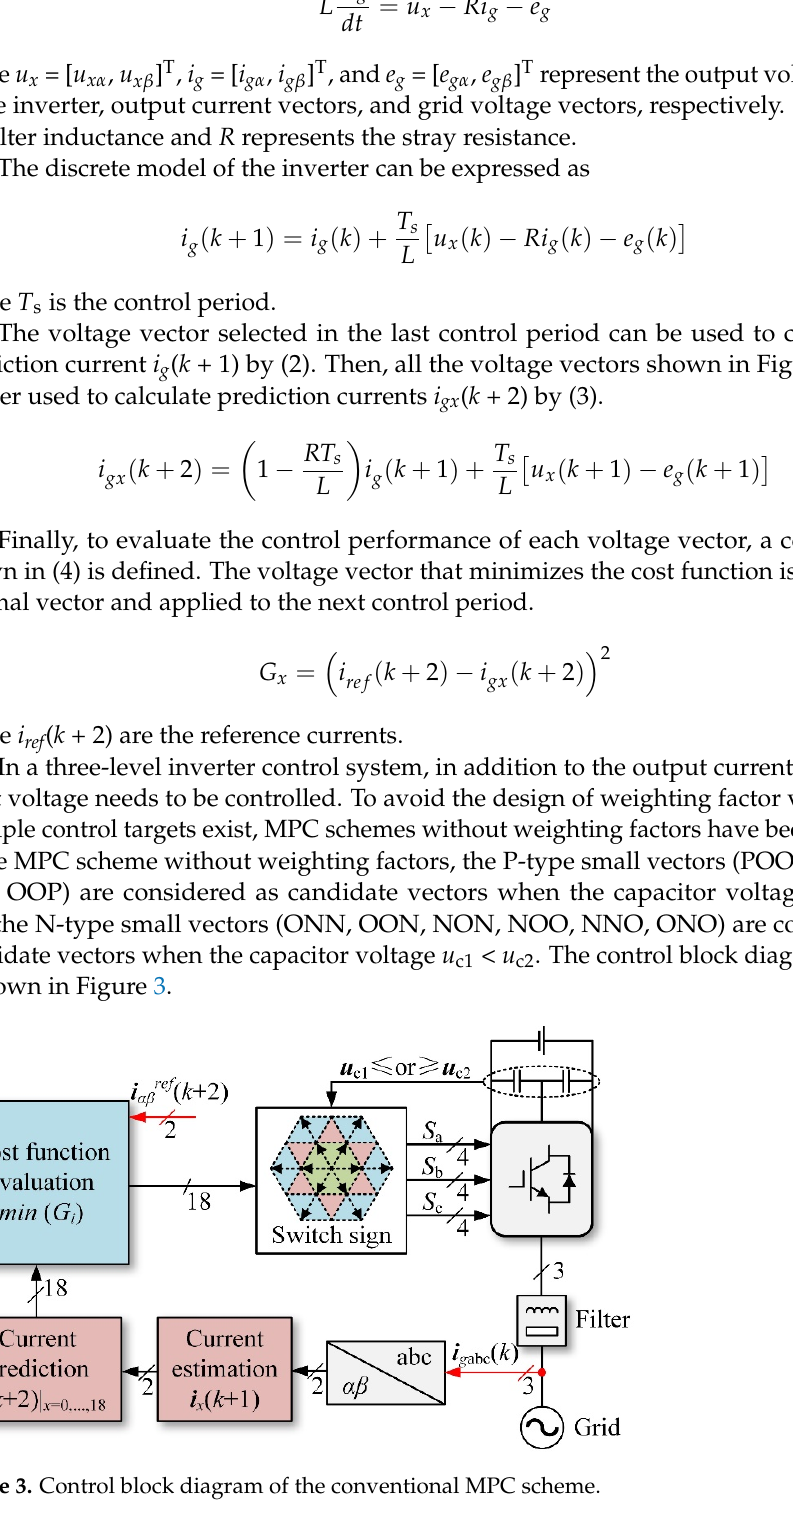
Figure 3. Control block diagram of the conventional MPC scheme.